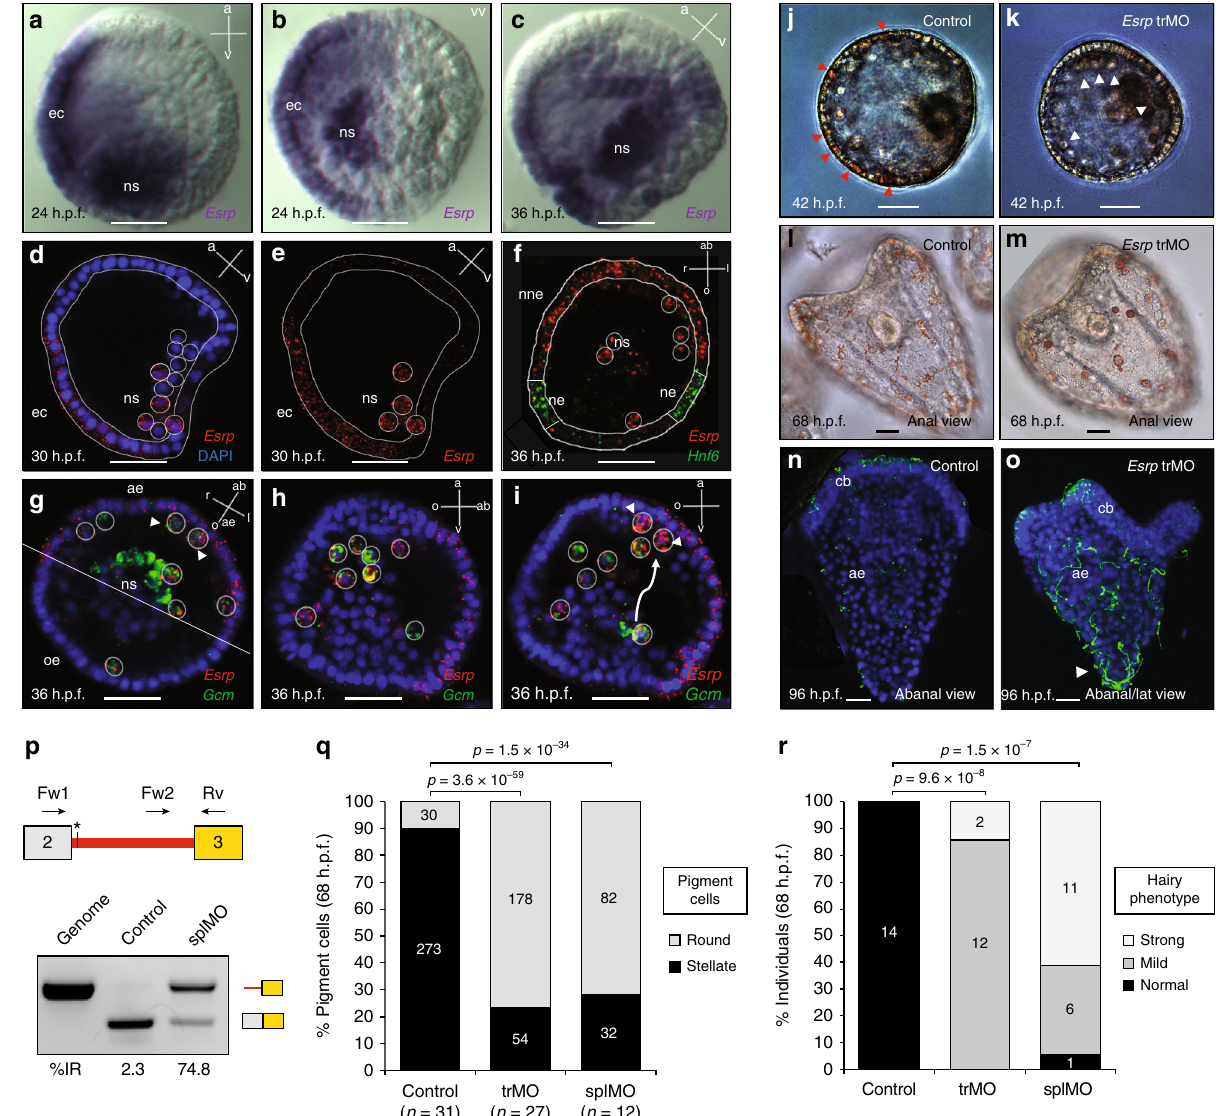
Fig. 4 Esrp represses cilia formation in aboral ectoderm and is necessary for complete MET of pigment cells. a , b Colorimetric WMISH of Esrp in sea urchin embryos at 24 h.p.f., in lateral a and vegetal b views, showed expression in one side of the ectodermal territory (ec) and in some cells of the non- skeletogenic mesoderm (ns). vv, vegetal view. c Lateral view at 36 h.p.f. con fi rmed Esrp ’ s asymmetric expression in one side of the ns mesoderm. d , e Fluorescent WMISH at 30 h.p.f. (lateral view) con fi rmed ectodermal and mesodermal expression of Esrp . f Double fl uorescent WMISH showed that Esrp expression (red) at 36 h.p.f. (animal pole view) did not overlap with the neurogenic ectoderm (ne) marker Hnf6 (green). nne, non-neural ectoderm. g Double fl uorescent WMISH of Esrp (red) and Gcm (green) at 36 h.p.f. (animal pole view) revealed that Esrp was expressed in the aboral ectoderm (ae) and in the pigment cell precursors. Pigment cell precursors that are already in contact with the ectodermal epithelium are marked by arrowheads. oe, oral ectoderm. h , i Esrp (green) and Gcm (red) at 36 h.p.f. in two different stacks from same embryo (lateral view). The arrow indicates a representative migratory path of pigment cells from mesoderm to ectoderm. At the top right corner of each panel a – i , the orientation of the depicted embryo along the animal [a] - vegetal [v], oral [o] – aboral [ab], left [l] – right [r] axes are reported, when possible. j , k Early gastrula (42 h.p.f.) from uninjected control and Esrp trMO embryos showed differences in pigment cell location. Red/white arrowheads indicate pigment cells already integrated into the ectoderm or in the sub-ectodermal space, respectively. l , m Early pluteus larvae (68 h.p.f.) in abanal view show differences in pigment cell morphology upon trMO treatment (roundish instead of stellate/dendritic). n , o Ectopic embryonic cilia stained with acTubulin in the aboral ectoderm (ae) of 96 h.p.f. Esrp -trMO injected embryos. Apex is marked by a white arrowhead. cb, ciliary band. p RT-PCRs showing the levels of intron 2 retention in Esrp transcripts from control and Esrp splMO embryos; genomic DNA was used as a reference for intron inclusion. The asterisk marks the position of the fi rst in-frame termination codon in intron-retained transcripts. q Quanti fi cation of pigment cell morphology in control, Esrp trMO and splMO knockdown 68 h.p.f. embryos (sum of three independent experiments). r Quanti fi cation of the ‘ hairy ’ phenotype in control, Esrp trMO and spMO knockdown 68 h.p.f. embryos (sum of two independent experiments). P -values correspond to 2-way q or 3-way r two-sided Fisher Exact tests. Hairy phenotype was considered “ mild ” when aboral ectoderm cells show long cilia (of similar or longer length than ciliary band cells) and “ strong ” when, in addition to the latter, larvae show particularly long cilia at the apex, as indicated by an arrowhead in panel o . Scale bars correspond to 20 µ